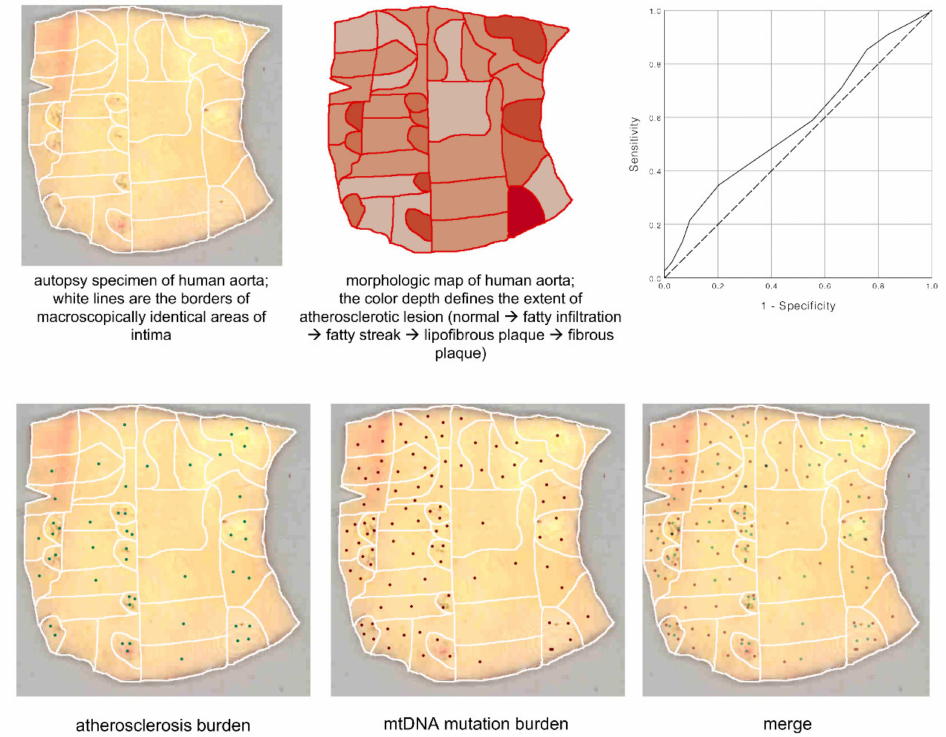
Figure 8. Co-localization of mtDNA mutation and atherosclerosis in human aortic intima. A significant correlation between mtDNA mutation burden and atherosclerosis burden was observed: r = 0.131, p = 0.034 (Spearman’s rho). The area under received operating characteristic (ROC)-curve for mtDNA mutation burden accounted for 0.587 (95% confidence interval (CI) 0.506–0.668, p = 0.041), the positive actual state was the presence of advanced atherosclerotic